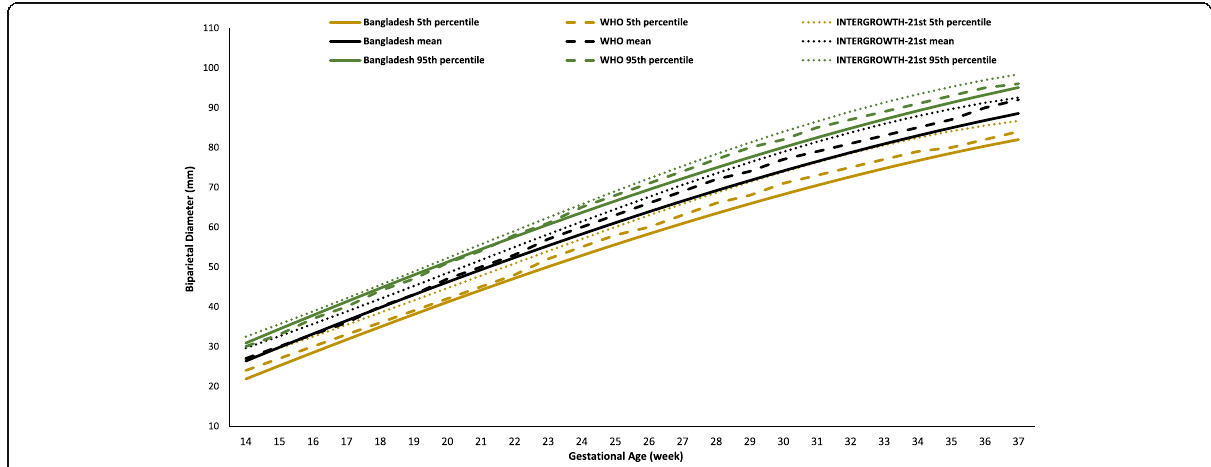
Fig. 2 Comparison of biparietal diameter (BPD) with WHO [11] and INTERGROWTH-21st [16] values